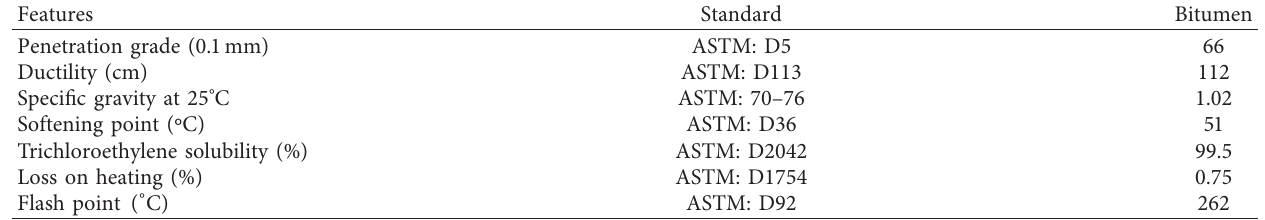
Table 2: The features of bitumen in the study.